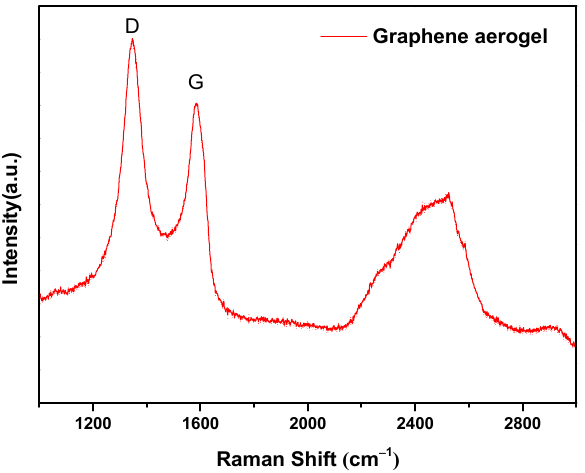
Figure 2. Raman spectra of GA.